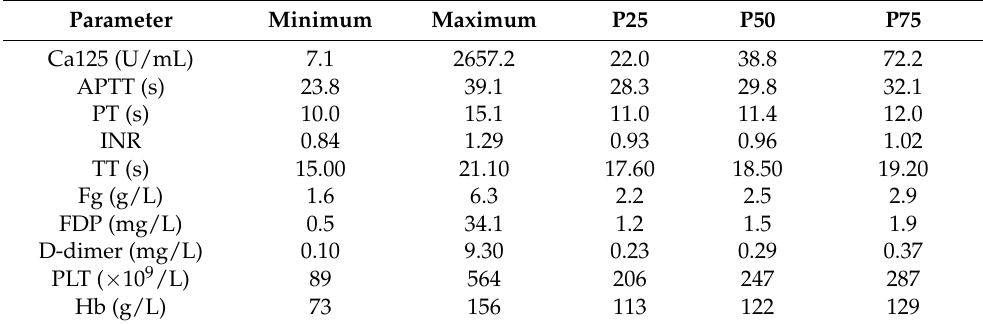
Table 3. Laboratory parameters of 491 subjects.